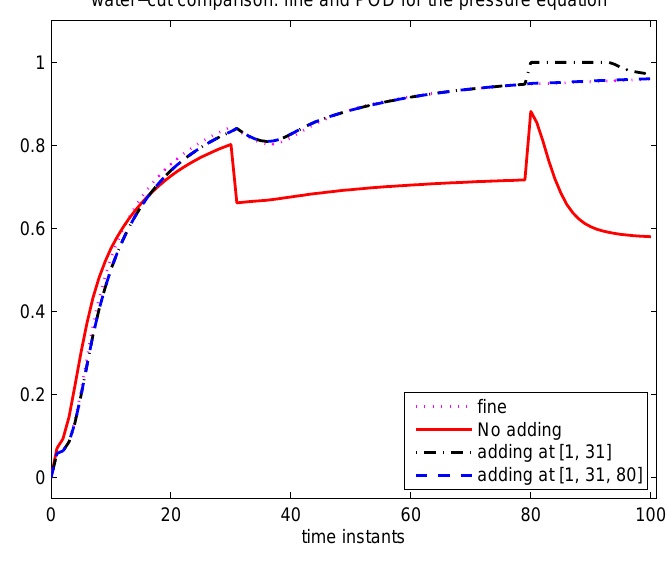
Figure 10. Water-cut of online adptive POD for the pressure